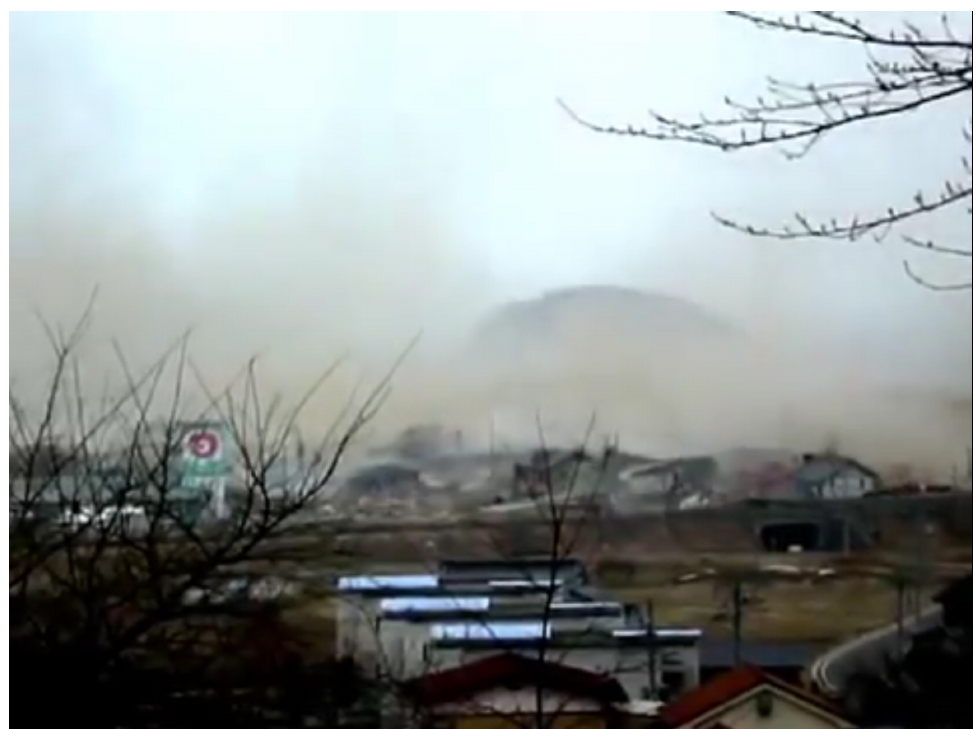
Figure 6: Great East Japan Earthquake on 11 March